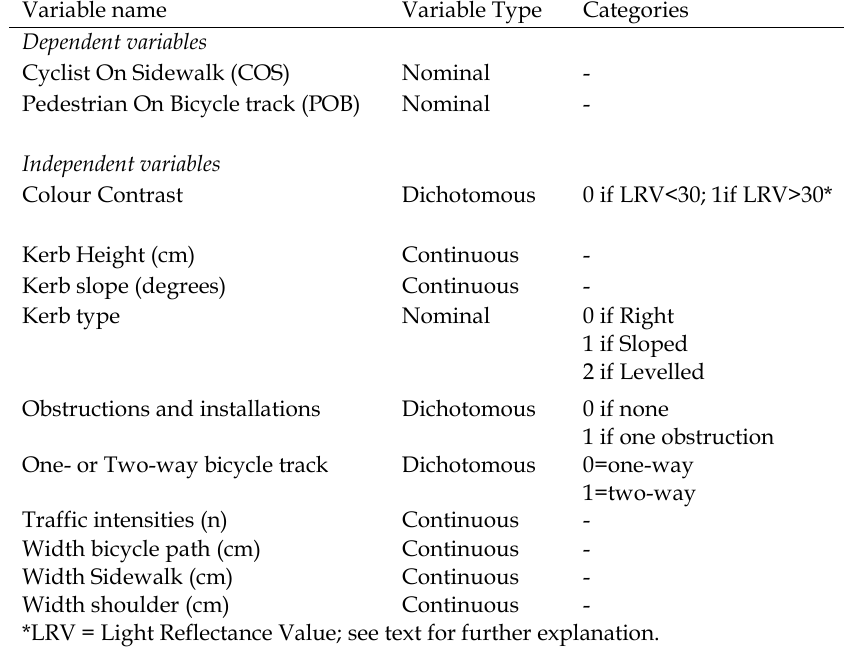
Included variables (dependent and